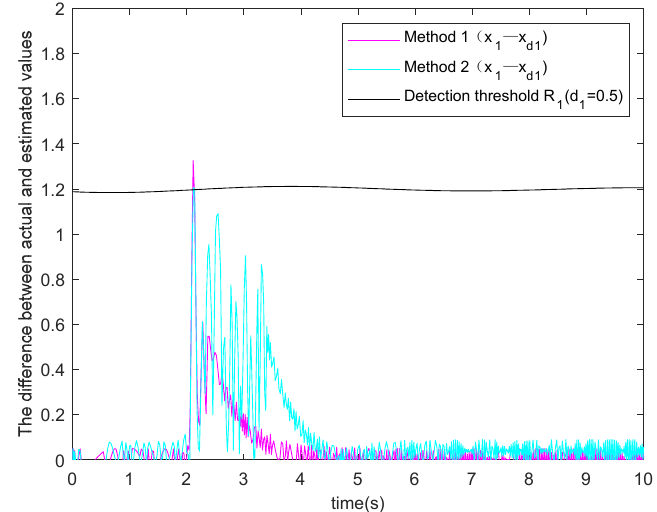
Figure 6. Fault tolerant control of the interconnection fault of subsystem 1.